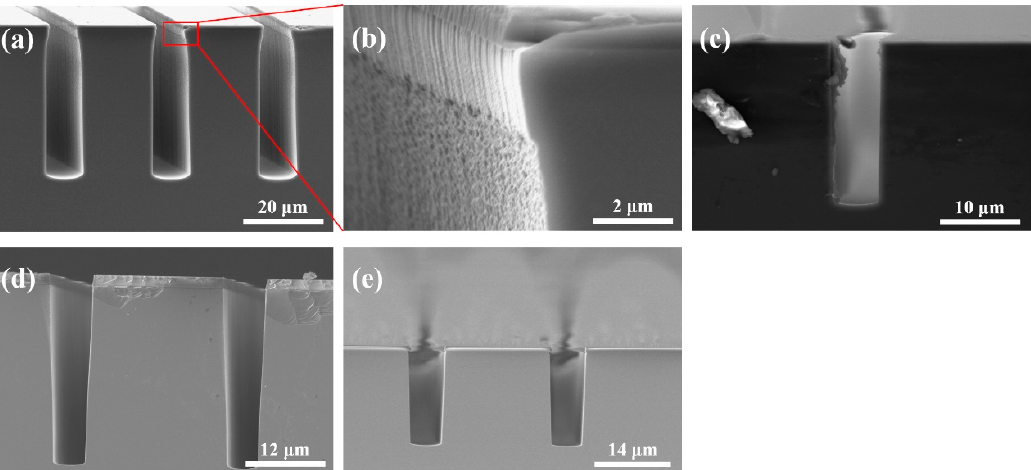
Figure 6. Etching results of cryogenic etching with different O 2 flows and process times: ( a ) Group 1: O 2 flow = 8 s ccm, time = 10 min, ( b ) local enlargement of the sidewall of Group 1, ( c ) Group 2: O 2 flow = 8.5 s ccm, time = 4 min, ( d ) Group 3: O 2 flow = 10 s ccm, time = 6 min, ( e ) Group 4: O 2 flow = 8 s ccm, time = 3.5 min.